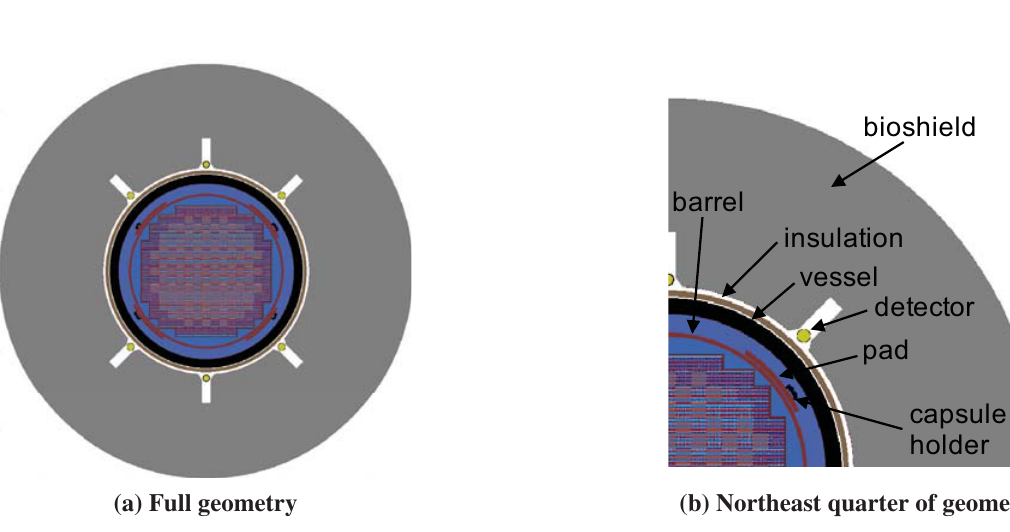
Figure 2: Raytrace of the WBN1 geometry at the core midplane ( z = 200